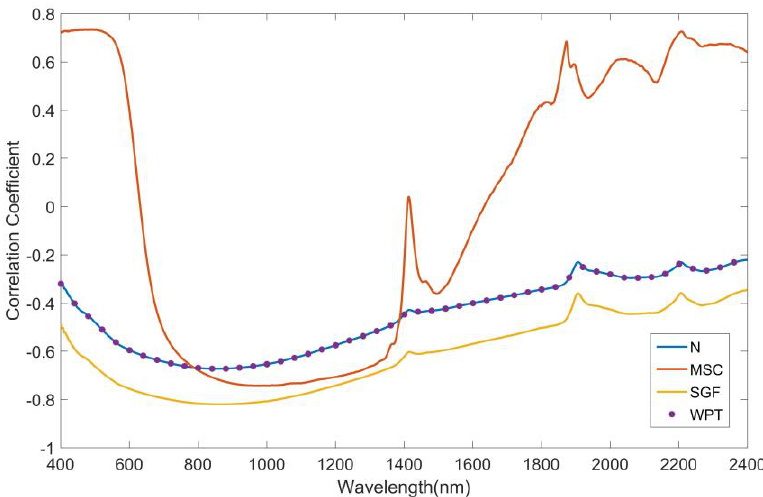
Figure 2. Comparison of correlation curves between the original spectrum preprocessed by di ff erent denoising methods and soil organic matter content. Abbreviations N, MSC, SGF, and WPT represent none, multiplicative scatter correction, Svitzky–Golay filter, wavelet packet transform, respectively. The correlation curves between reflectance and SOM content after fractional derivatives are shown in Figure 3. As the order increases from 0 to 0.6, the region with high correlation in the correlation curve gradually moves to the visible range. At order 0, the band range with correlation coe ffi cient greater than 0.5 is 514–1350 nm. At order 0.6, the band range with correlation coe ffi cient greater than 0.5 is 446–1085 nm. From order 0 to 0.6, the peak of correlation coe ffi cient increased from 0.6726 to 0.6934, and the band range with correlation coe ffi cient greater than 0.67 moved from 807–905 nm to 539–787 nm. Starting from order 0.8, the correlation curve produces irregular fluctuations. As the order increases from 0.8 to 2, the fluctuation amplitude of the correlation curve increases rapidly, and the overall correlation coe ffi cient tends to be between − 0.2–0.2 gradually.